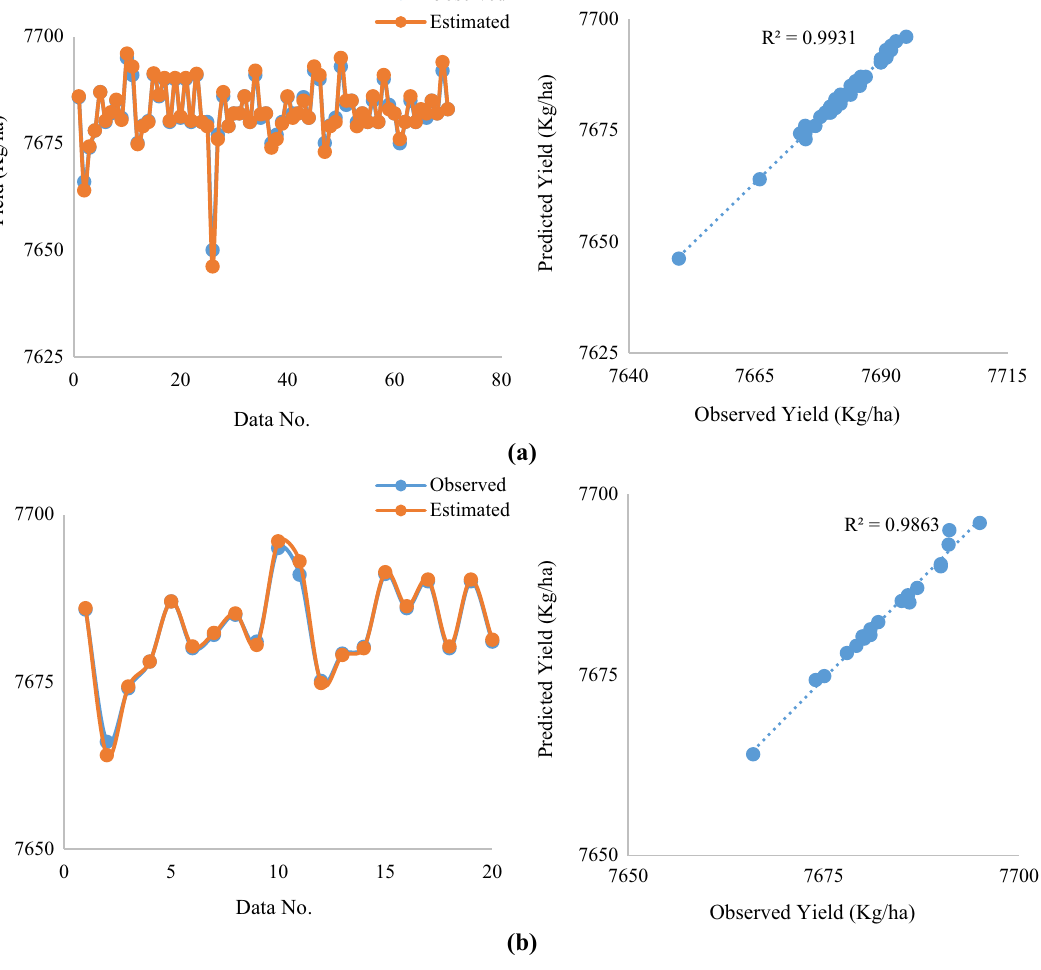
Fig. 7 a , b Comparison of predicted Yield with observed values a ACVO-ANFIS on test dataset b ACVO-ANFIS on the training